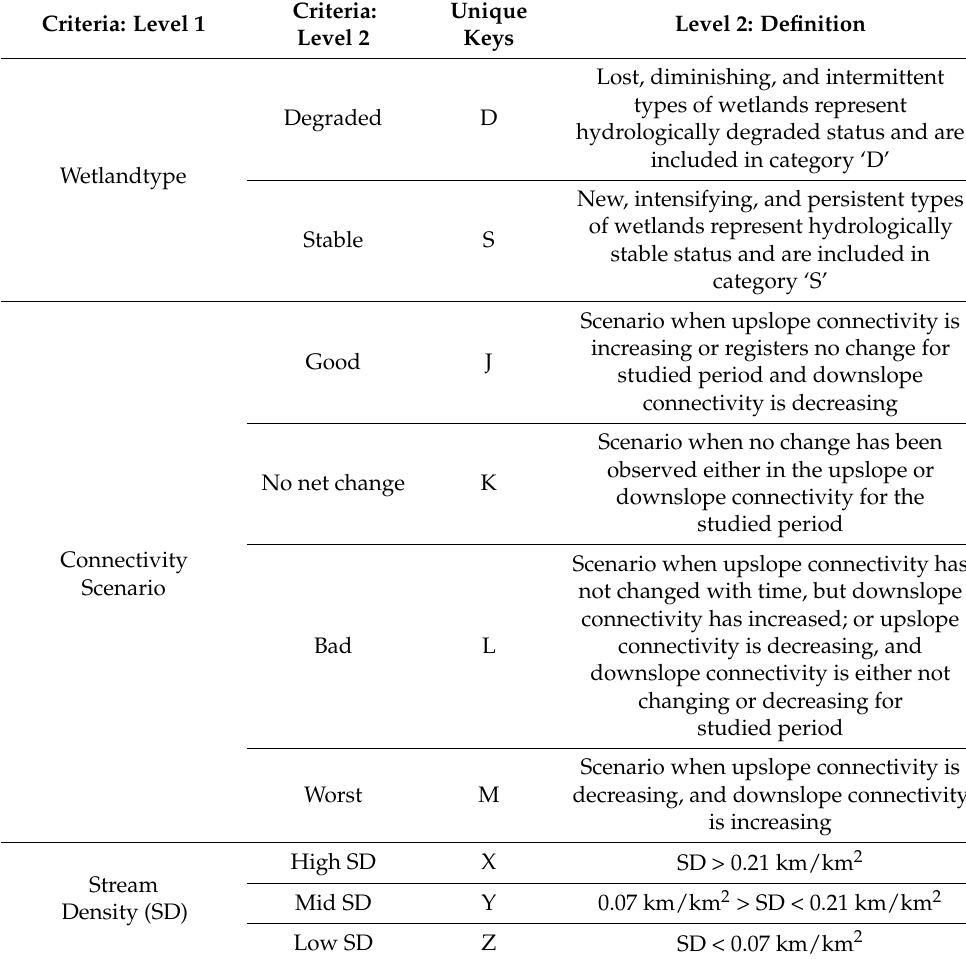
Table 2. List of criteria used in the prioritisation